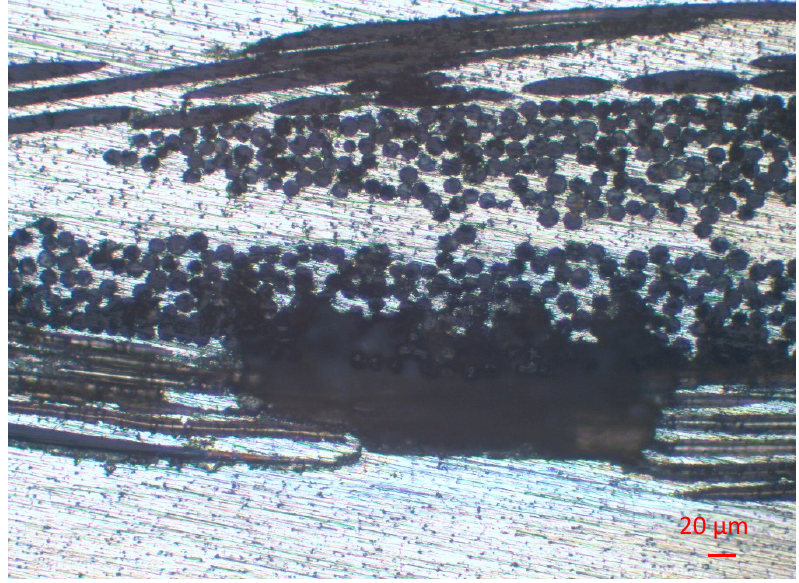
Figure 5. Nonhomogeneous impregnation of basalt woven fabric (BWF) by molten AZ63.